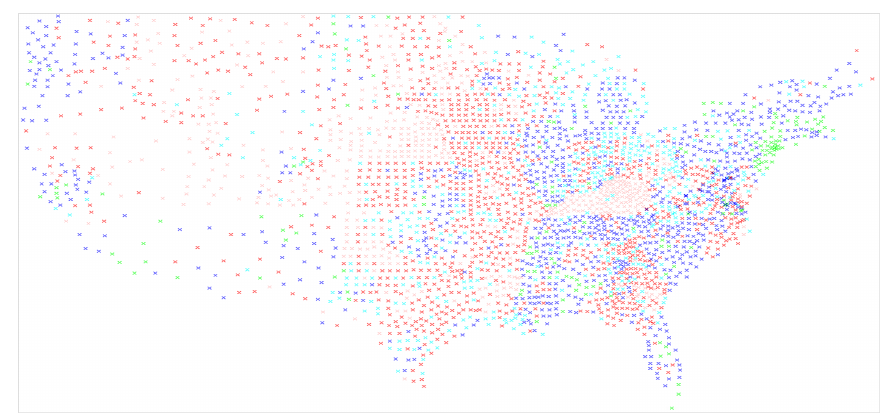
Figure 3: From WEKA: Indicative Map of US